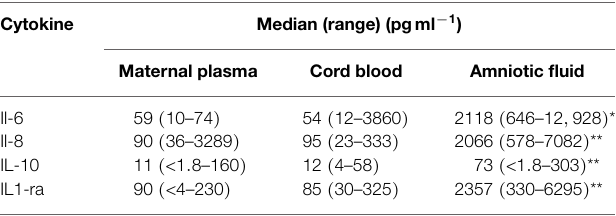
TABLE 2 | Comparison of median cytokine levels (pgml (cid:0) 1 ) in matched samples of maternal plasma, cord blood and amniotic fluid collected from elective cesarean deliveries ( n = 24)